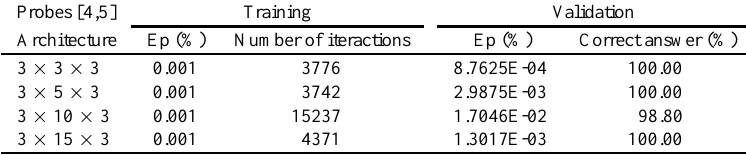
Table 2 Training and validation results for the group (b) classification neural networks